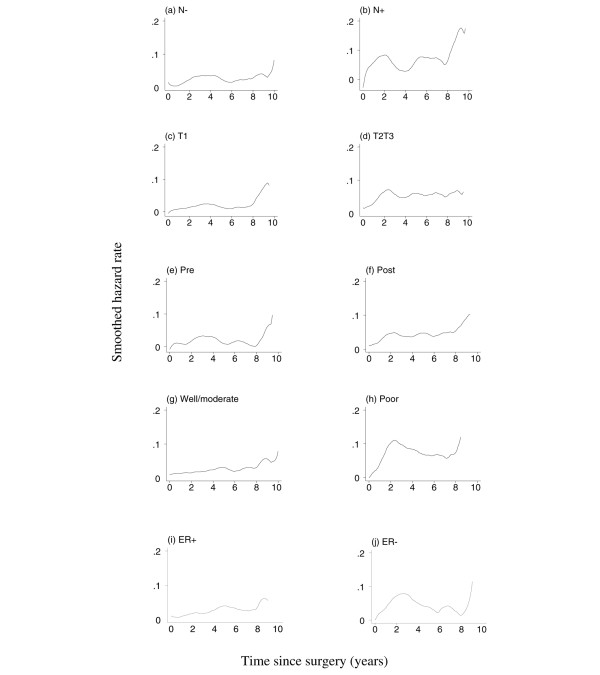
Smoothed hazard for death in ethnically Chinese breast cancer patients having mastectomy alone. (a) Lymph node negative. (b) Lymph node positive. (c) Pathological T1. (d) Pathological T2 or T3. (e) Premenopausal. (f) Postmenopausal patients. (g) Well to moderately differentiated. (h) Poorly differentiated. (i) ER positive. (j) ER negative. Note that the tail of the curve was removed because of the small number of available data. ER, oestrogen receptor.